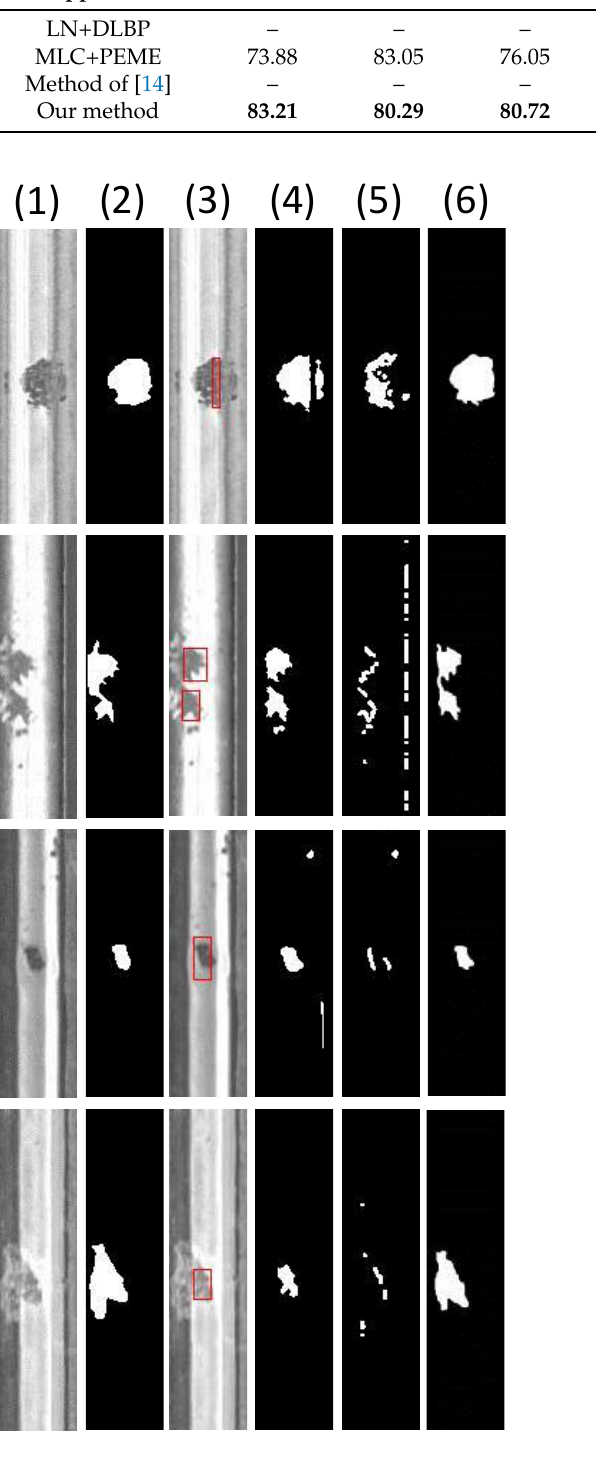
Figure 9. Sample defect images and inspection results for different methods from the Type-II RSDDs data set. ( 1 ) Defect, ( 2 ) ground truth, ( 3 ) LN+DLBP, ( 4 ) MLC+PEME, ( 5 ) method of [14], and ( 6 ) our method. The defect detected in LN+DLBP is marked by a red